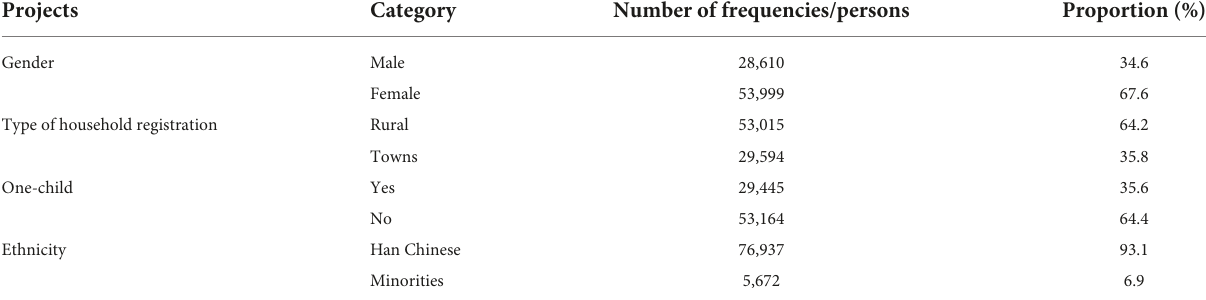
TABLE 1 Table of data